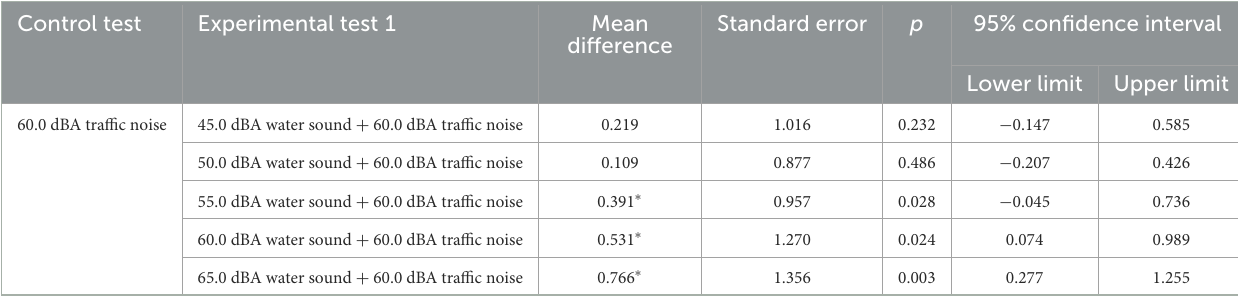
TABLE 2 Comparisons between the psychological health values on the emotional dimension in the control test and experimental test 1.